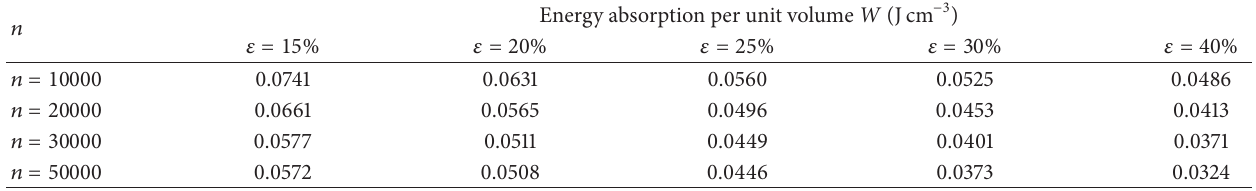
Table 6: Energy absorption per unit volume of paper honeycomb under various precompression (23 ∘